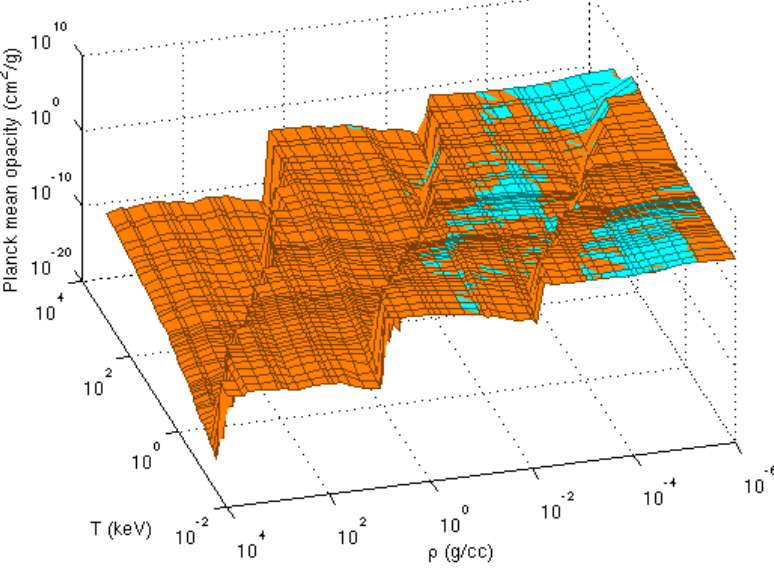
Figure 20. Iron Planck mean opacities of a calculation with a maximum number of 1000 superconfig- urations and a maximum number of 10,000 superconfigurations as a function of temperature and